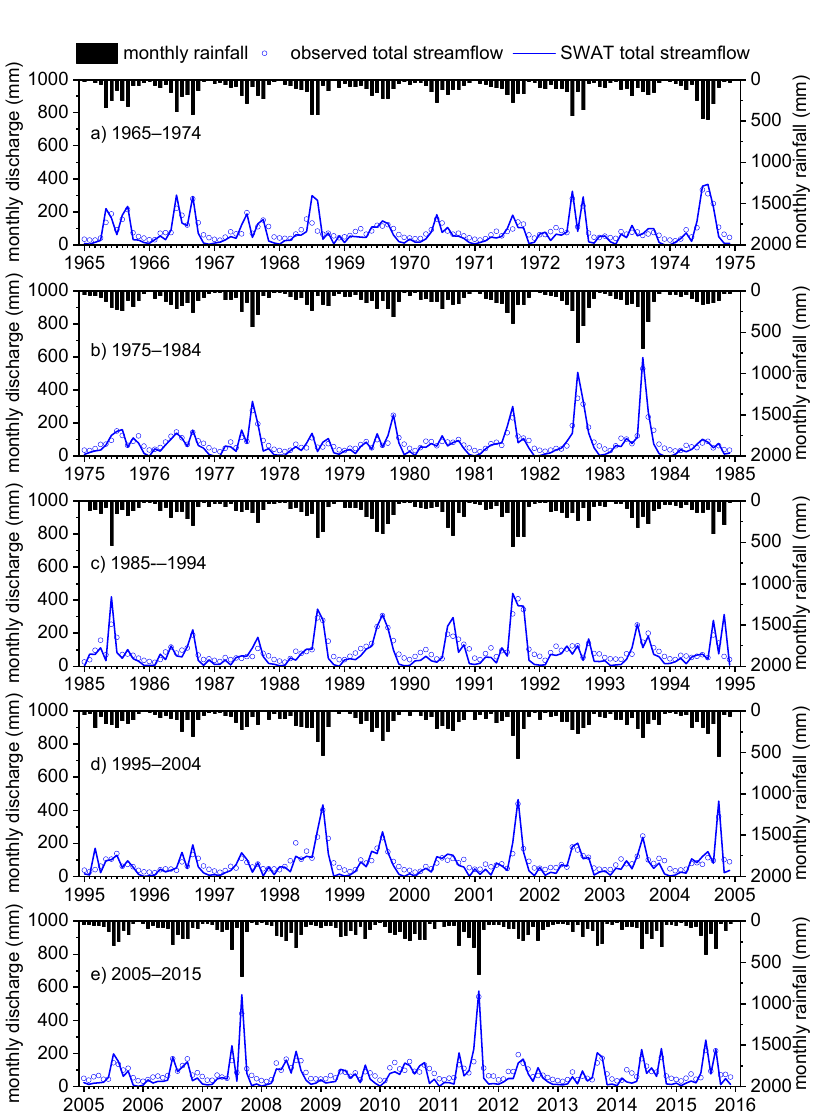
Figure 7. Monthly total streamflow hydrographs of the initial calculation in each decade: ( a ) 1965 – 1974, ( b ) 1975 – 1984, ( c ) 1985 – 1994, ( d ) 1995 – 2004, and ( e ) 2005 – 2015.